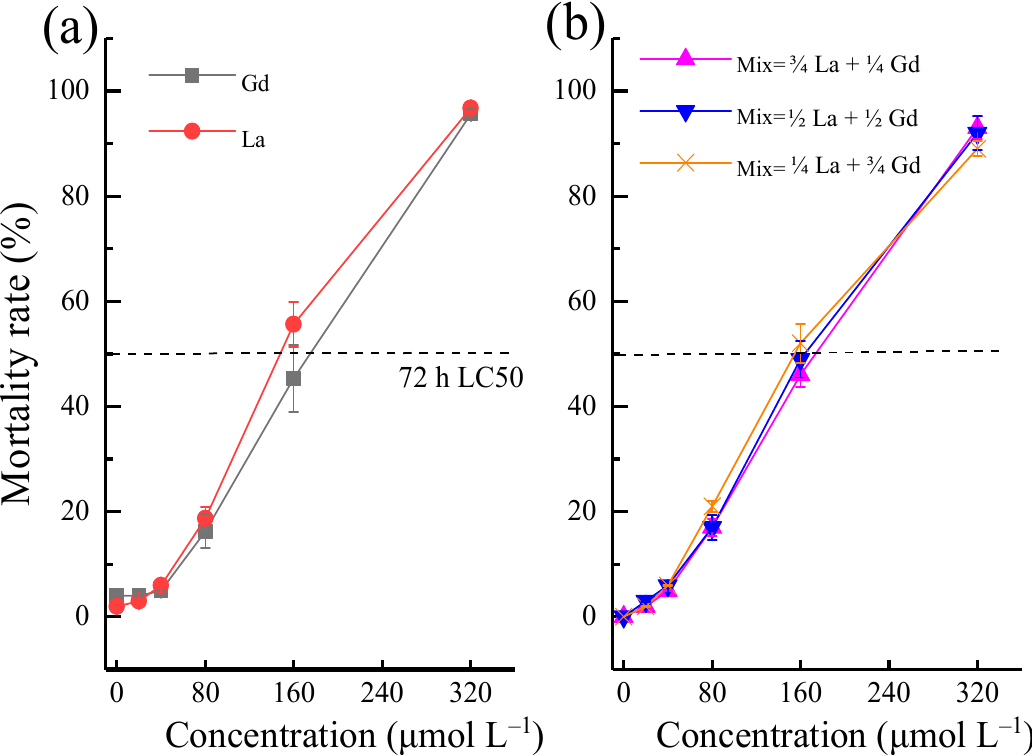
Figure 1. Toxic effects of La, Gd, and the Mix on Danio rerio : ( a ) acute toxicity (72 h-LC50) of La and Gd on Danio rerio ; ( b ) acute toxicity of the mixture (Mix) containing La and Gd determined from an equimolar concentration combination. Table 1. La and Gd uptake and bioconcentration factors ( BCF ) in muscle, gills, and liver tissues of Danio rerio exposed to 15 and 30 μ mol L − 1 La and Gd for 28 days, respectively.